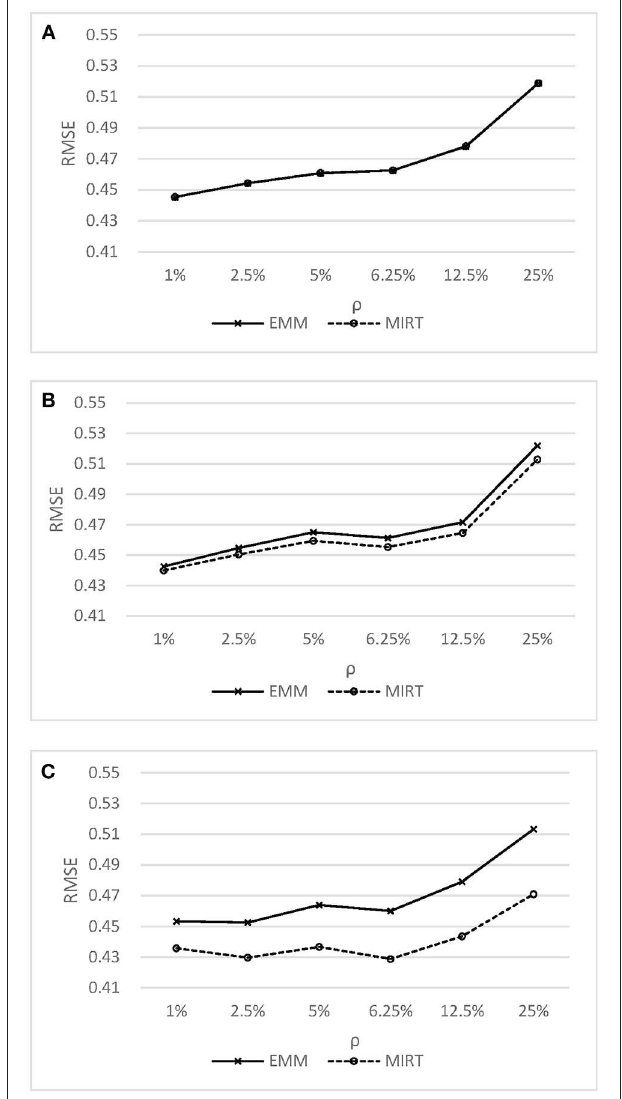
FIGURE 2 | RMSE of ability estimates under the Effort Moderate Model MIRT model. (A) y = 0.0 (B) y = 0.4 (C) y =